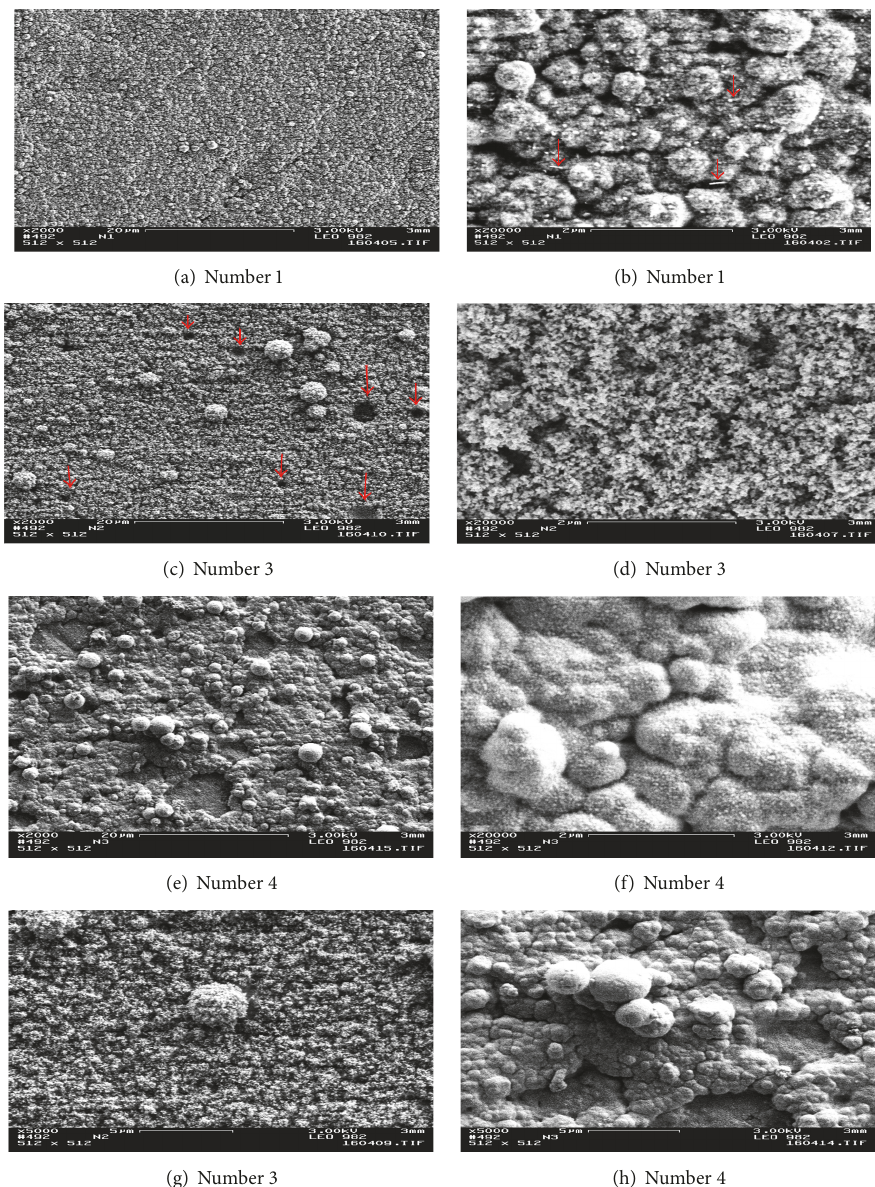
Figure 3: SEM images with various increases showing evolution of the forms annealed on a titanic foil at 773 K coatings from NPles: (a, b) pure ZnO (sample number 1) and carbon-doped samples: (c, d) sample number 3 (2.4% C) and (e, f) sample number 4 (2.5% C).